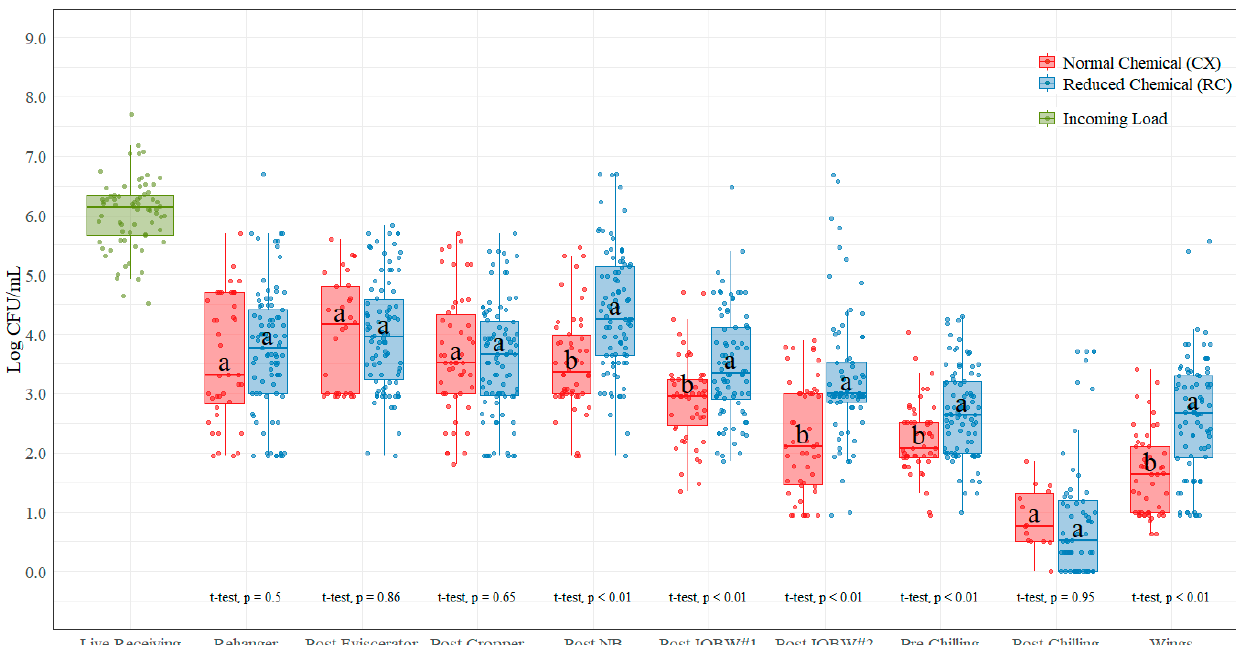
Figure 3. Enterobacteriaceae counts (log CFU/mL) on each of the ten locations during the eviscera- tion process under normal process interventions (CX) and low-chemical process interventions (RC) on chicken rinses. In each boxplot, the horizontal line crossing the box represents the median, the top and bottom lines of the box represent the lower (0.25) and upper (0.75) quartiles, the vertical top lines represent 1.5 times the interquartile range, and the vertical bottom line represents 1.5 times the lower interquartile range. The dots represent the actual data points. a,b For each location, boxes with different letters are significantly different between treatments according to t -test analysis at p -value < 0.05.